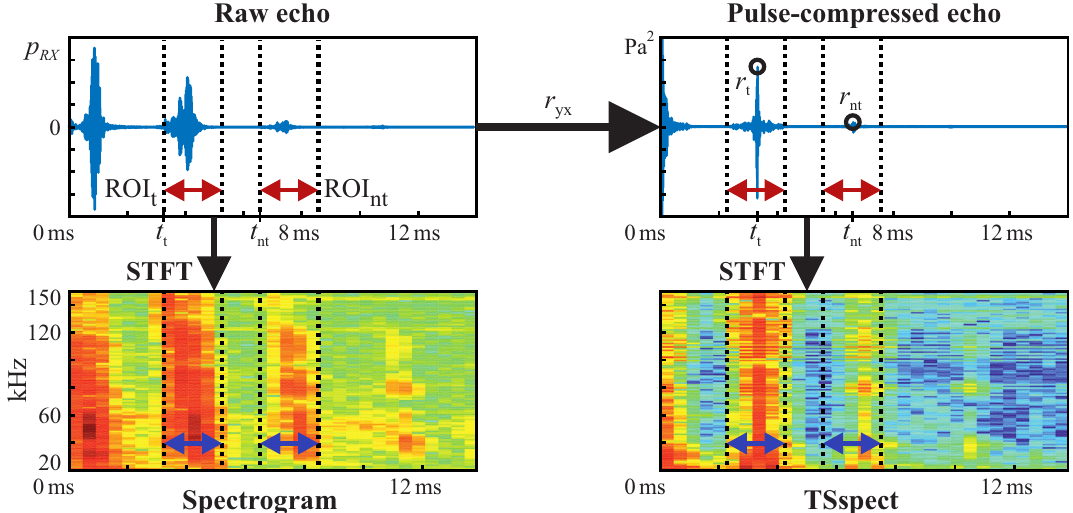
Figure 5. Main calculation steps from raw target/non-target echo pressure signal p RX to spectrogram feature ( Spect ), total TS estimate feature ( TStot via r t / r nt from cross-correlation r yx with excitation signal) and spectral TS estimate feature ( TSspect ). ROIs (ROI t /ROI nt ) are illustrated by dotted lines and enclosed arrows. Echo delays are indicated by t t and t nt